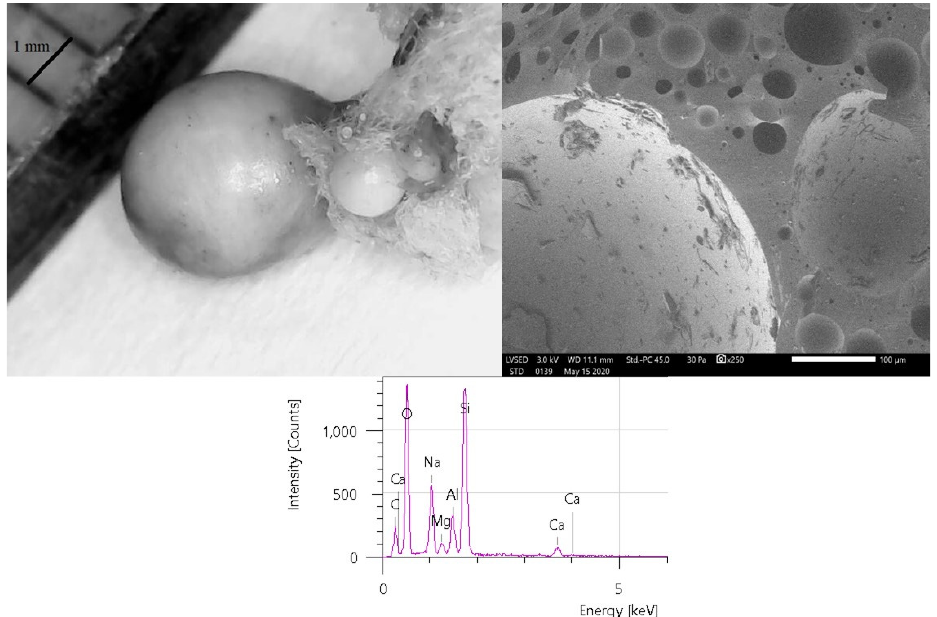
Figure 9. The optical microscopy (left), scanning microscopy (right), and EDS measurement results (down) of the burned sample.